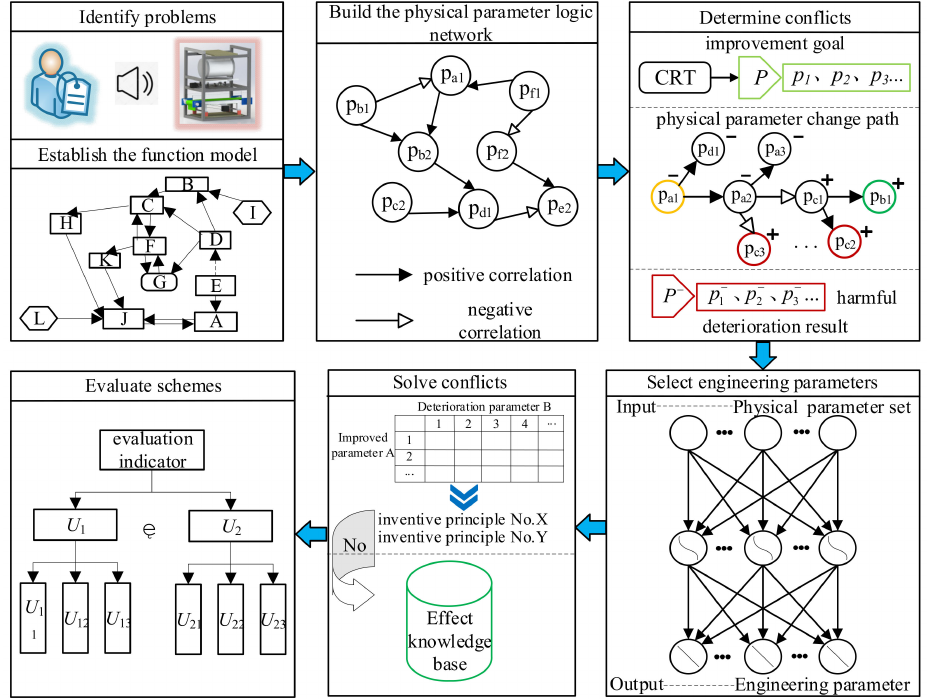
Figure 8. Conflict solving process based on mapping between physical parameters and engineering